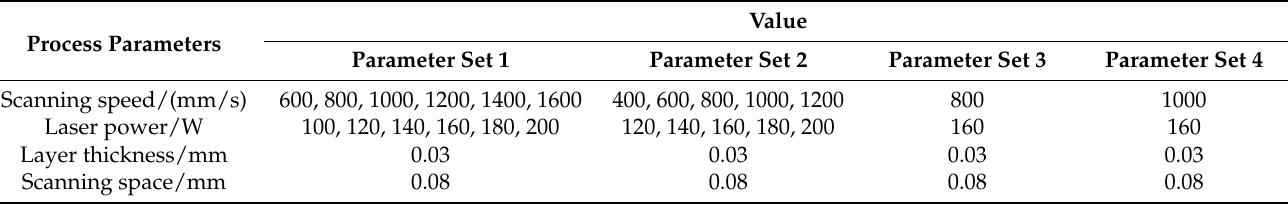
Table 2. Forming process